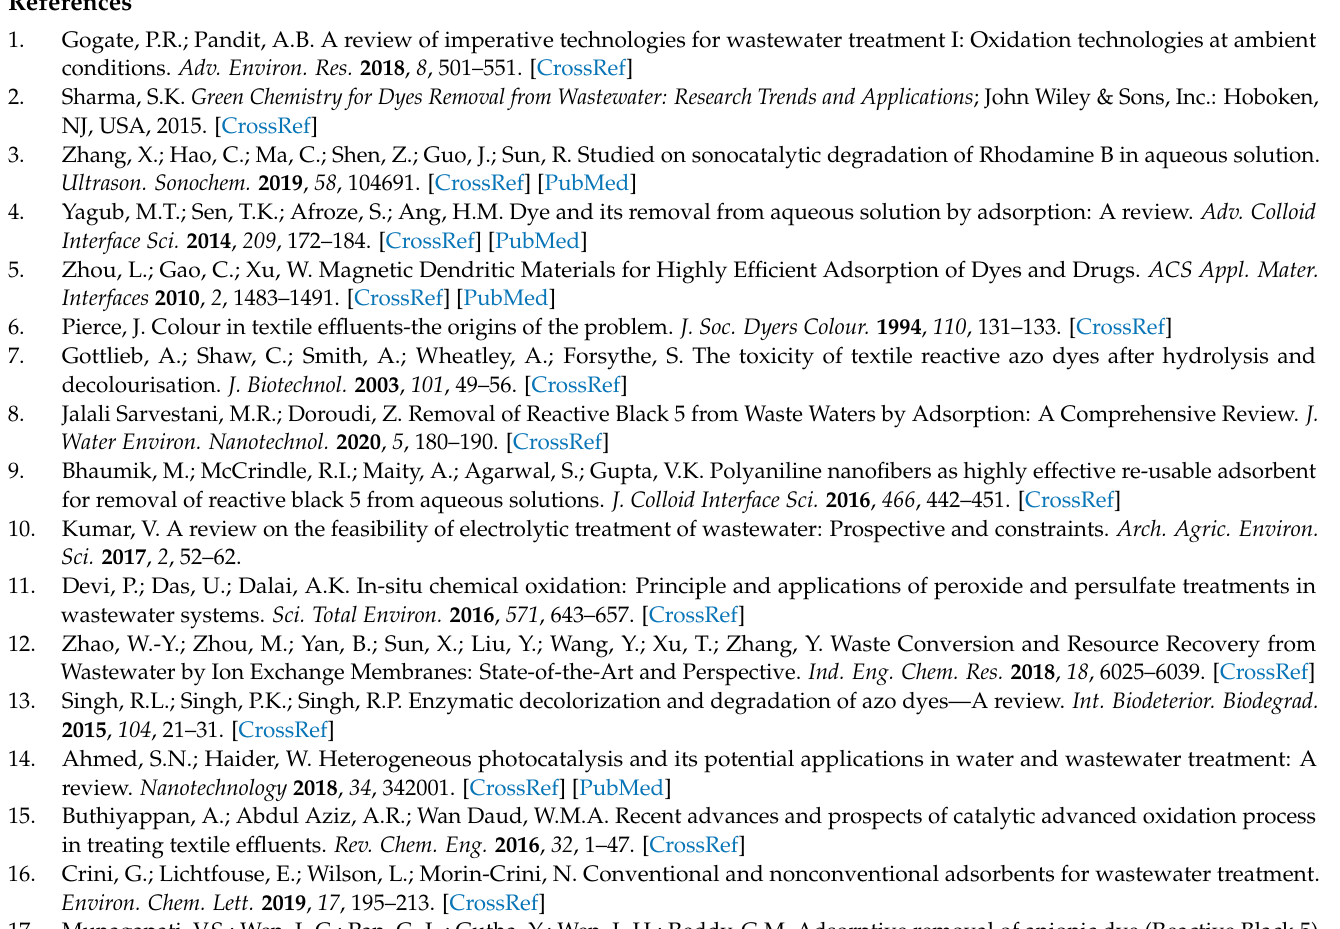
concentration. Table S4: The functions used to adjust membrane adsorption capacity as a function of time and initial dye concentration (Akaike Information Criterion, AIC, was used for each model). Table S5: The time-dependent and parameter-dependent log-logistic formula per membrane and initial dye concentration. Table S6: The optimal conditions found by the RSM at t = 120 min (Top position), the optimal dye concentration at 100 mg L − 1 and pH = 2 (Medium position), and the pseudo-optimal conditions at 40 mg L − 1 and pH = 2 (Bottom